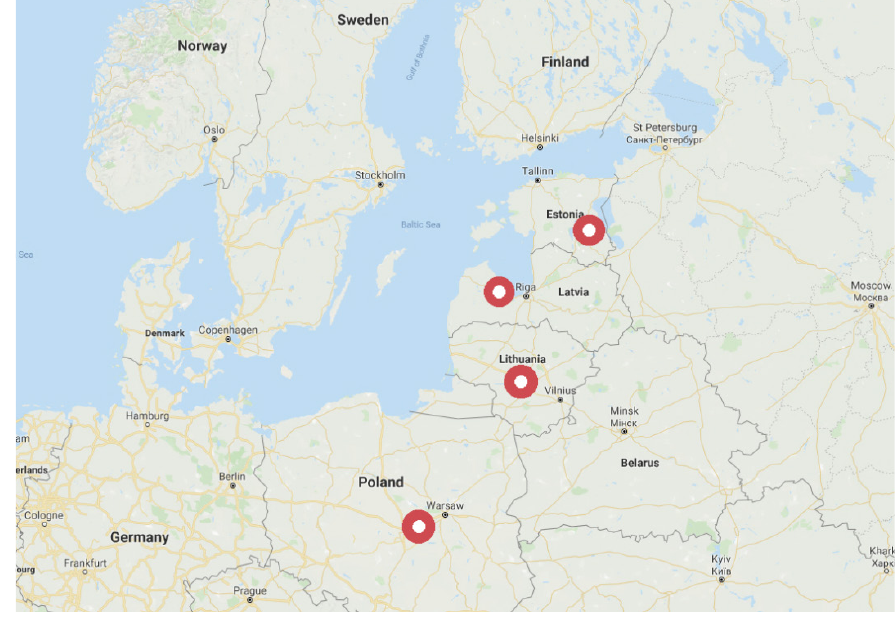
Fig. 1. Map of trial site locations (source: Google